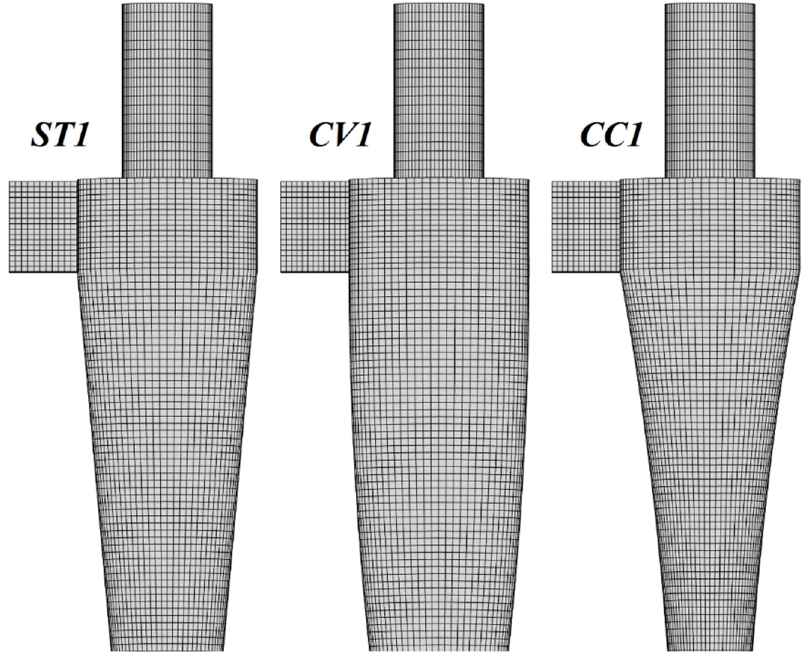
Figure 3. Sample mesh regions for all cyclone models ST1, CV1, and CC1. Three levels of the grid are considered viz. 214K, 386K and 568K (from left to right), respectively.